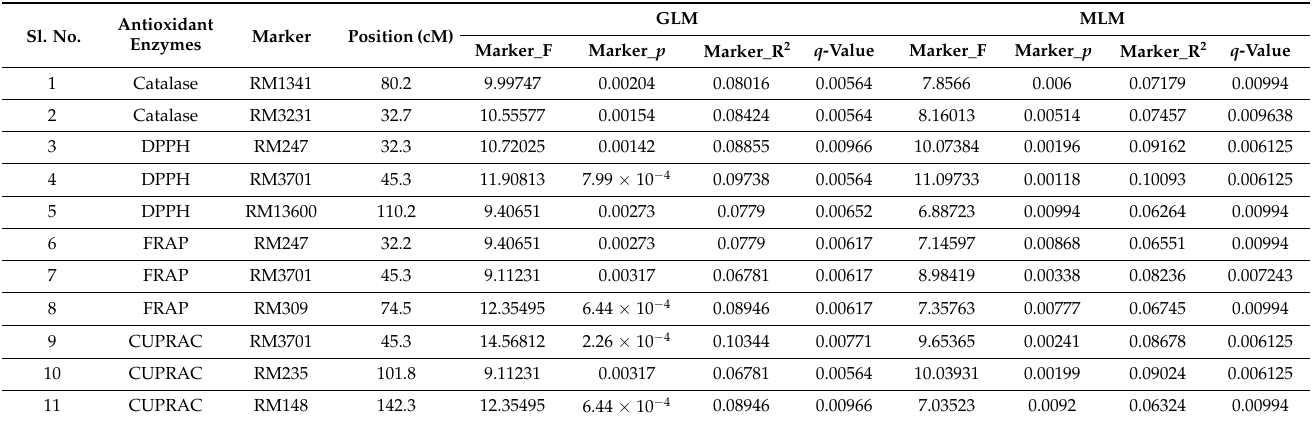
Table 4. Marker–trait associations with antioxidant traits catalase, peroxidase, DPPH, FRAP and CUPRAC in the panel population detected by both GLM and MLM at p <